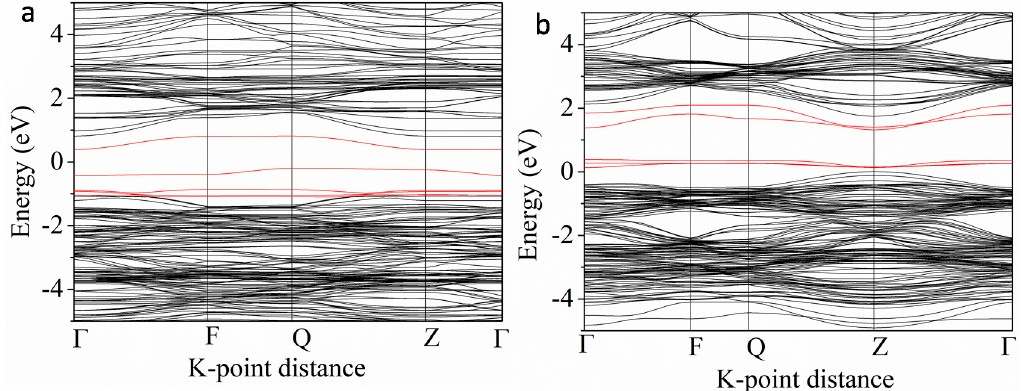
Figure 8. The band structures of Nb-Mn ( a ) and Nb-Co ( b ) co-doped BaTiO 3 . The red lines indicate Mn 3d states ( a ) and Co 3d states ( b ).